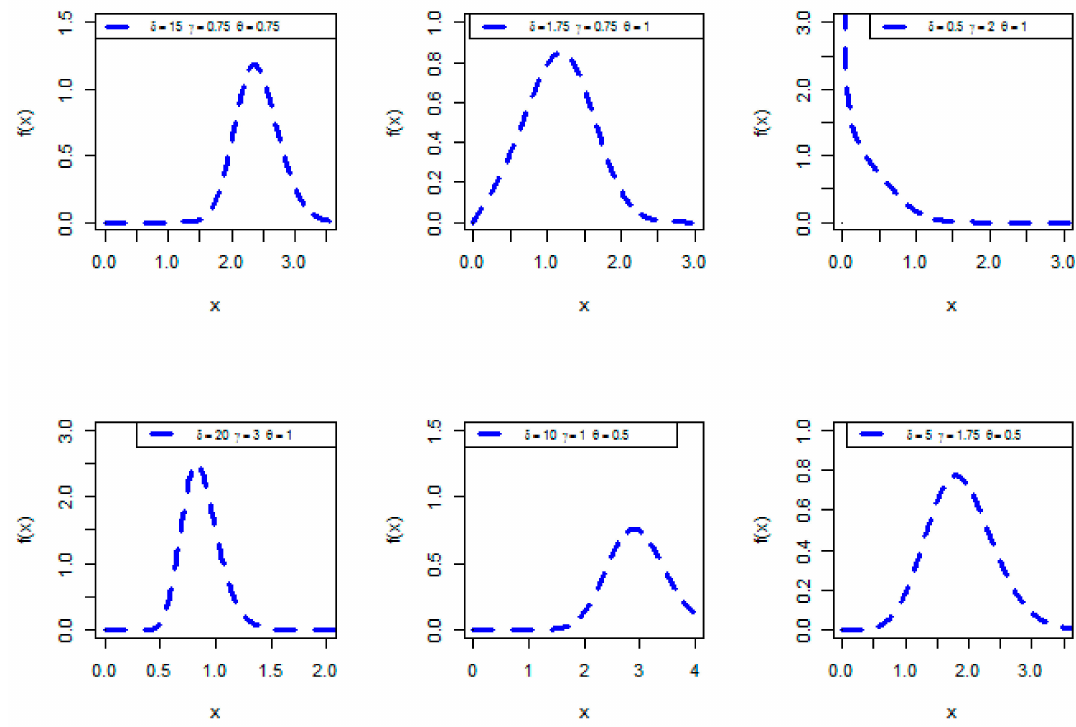
Figure 1. Plots of the odd exponentiated half-logistic exponential (OEHLE) probability density function (PDF) for some parametric values.